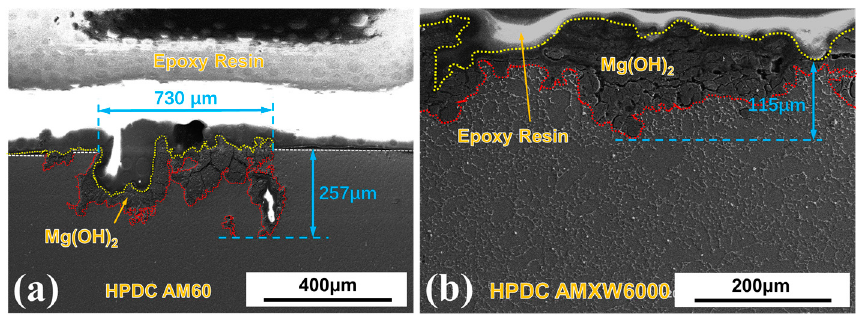
Figure 6. Cross sectional SEM images of HPDCed ( a ) AM60 alloy and ( b ) AMXW6000 alloy after 4 days immersion.